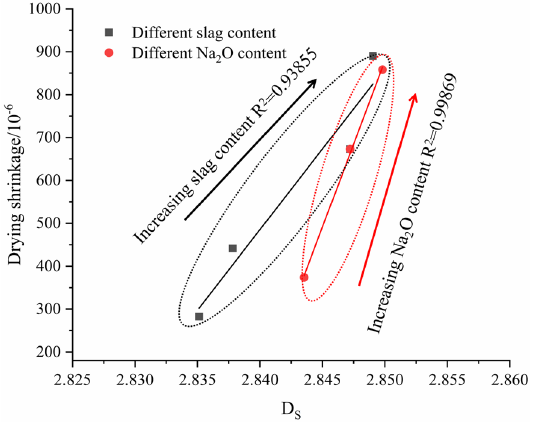
Figure 17. Relationship between the fractal dimension and drying shrinkage.